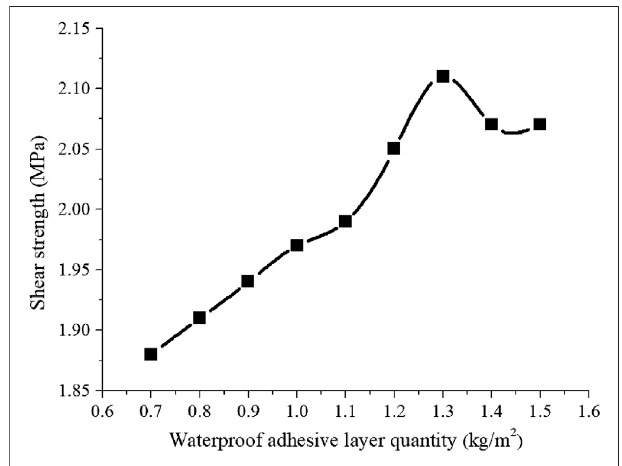
FIGURE 3 | Shear strength variation with adhesive layer